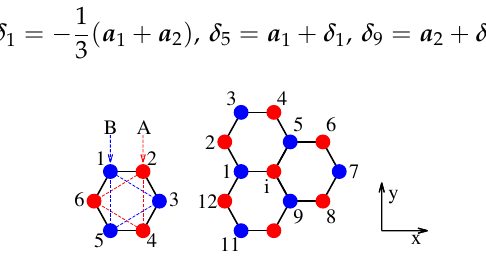
Figure 5. The unit cell ( left ) and the supercell ( right ) of a hexagonal lattice. The cells exhibit armchair edges in the x -direction and along rows with angle 2 π /3 with respect to the x -axis and zigzag edges in the y -direction and along rows with angle π /3 with respect to the x